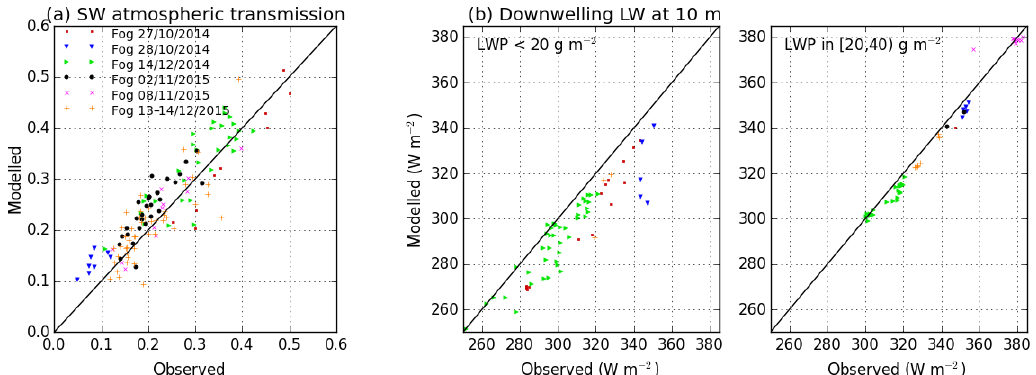
Figure A1. Comparison of modelled and measured SW and LW downwelling radiative flux at 10m during the six fog cases without a higher cloud (Table 2): (a) atmospheric SW transmission (fraction of downwelling SW at 10m and at the top of the atmosphere), including only times when observed flux exceeds 10Wm − 2 ; (b) downwelling LW flux at 10m, in cases where fog LWP is estimated to less than 20gm − 2 and between 20 and 40gm − 2 .